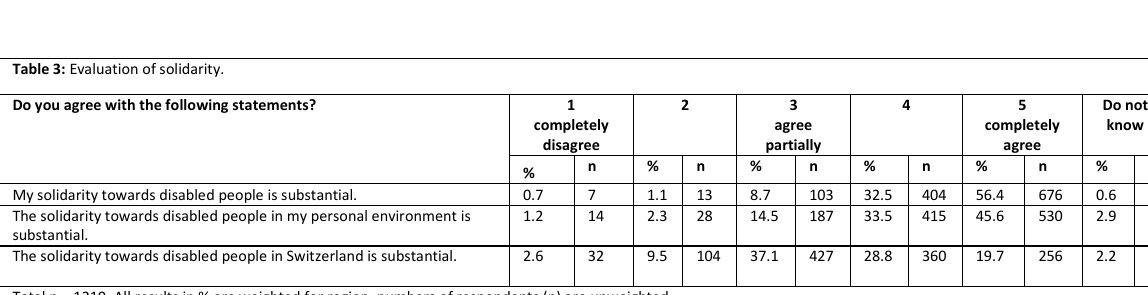
Table 3: Evaluation of solidarity.